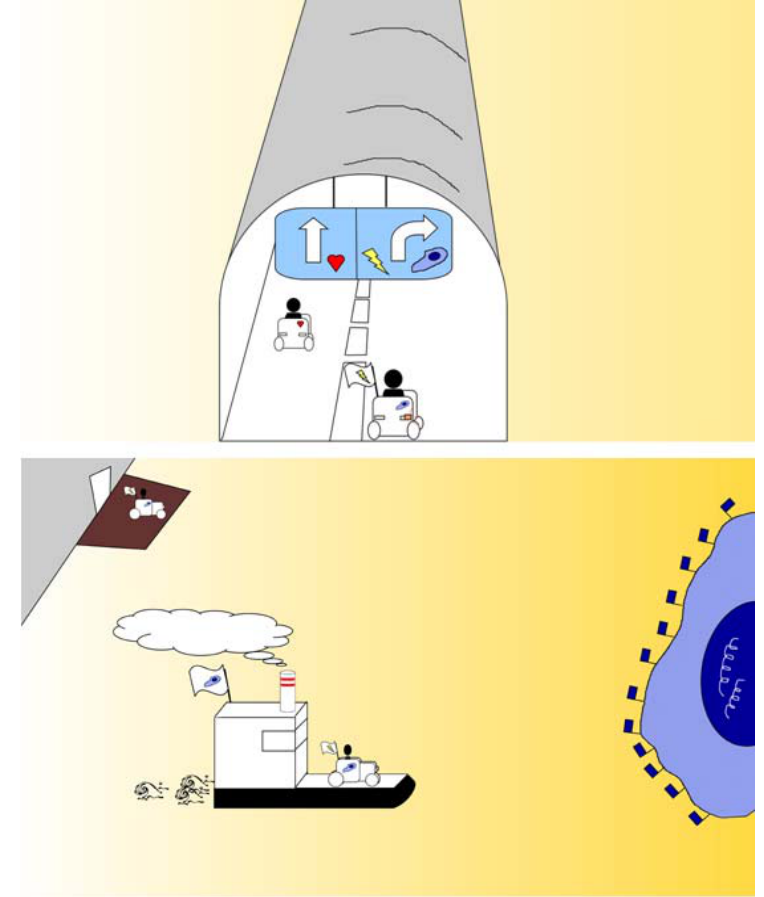
Figure 5. These two sketches thematise “flagging and ferrying”. The upper image represents the blood microvessel as a tunnel, such as found along a motorway. The vehicle at left (representing a nanoparticle) encounters no road-sign or flag to show the route to a lesion, and therefore continues driving straight. The vehicle at right encounters a roadsign or flag showing that a lesion can be found behind the tunnel (microvessel) wall and that a right turn will access the lesion. The lower image shows the vehicle after turning right out of the tunnel (microvessel) and now packed onto a ferry (for example, a caveolus) which is transporting it to the lesion, a tumour cell, shown as a blue island bearing blue flags at the right side of the